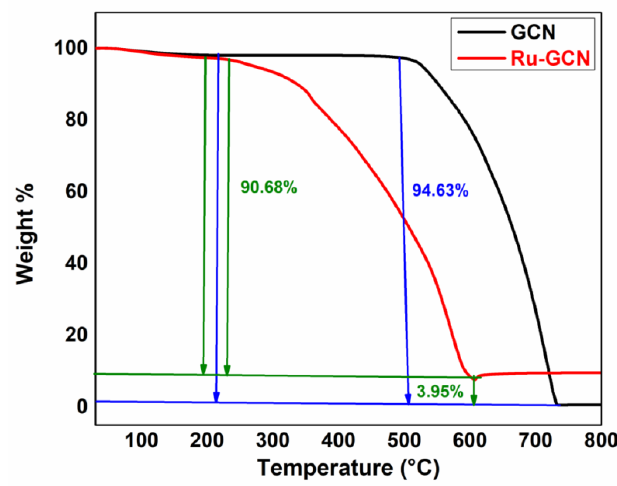
Figure 6. Thermogravimetric analysis (TGA) of GCN and Ru-GCN material.